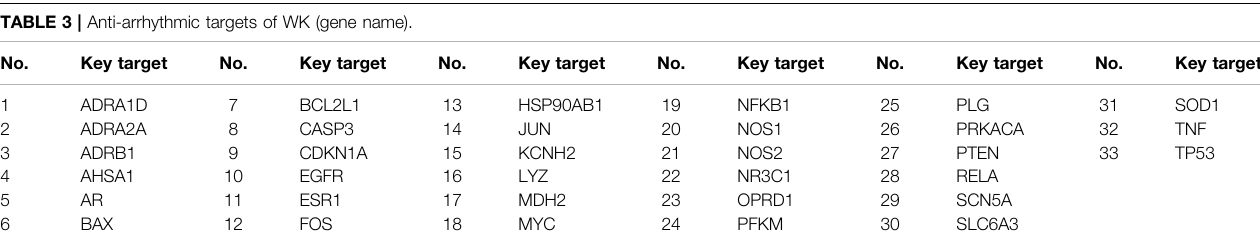
TABLE 3 | Anti-arrhythmic targets of WK (gene name).